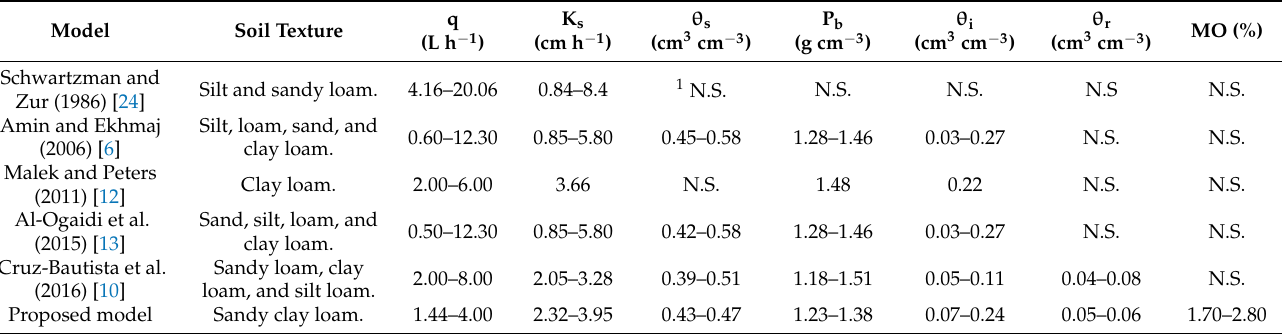
Table 5. Validity ranges of the evaluated